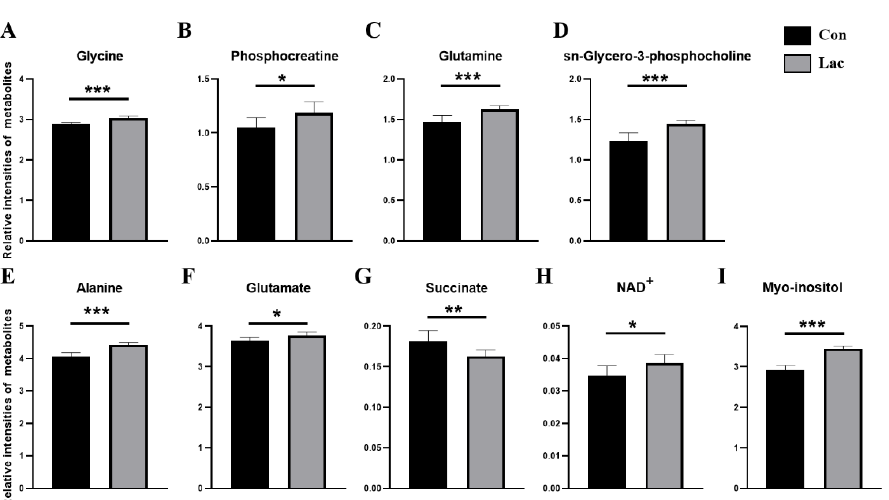
Figure 6. Quantitative comparison of relative levels of differential metabolites between the two groups of myoblasts. ( A ) Glycine ( B ) Phosphocreatine ( C ) Glutamine ( D ) sn-Glycero-3-phosphocholine ( E ) Alanine ( F ) Glutamate ( G ) Succinate ( H ) NAD+ ( I ) Myo-inositol. * p < 0.05, ** p < 0.01, *** p < 0.001. n = 8 for each group.